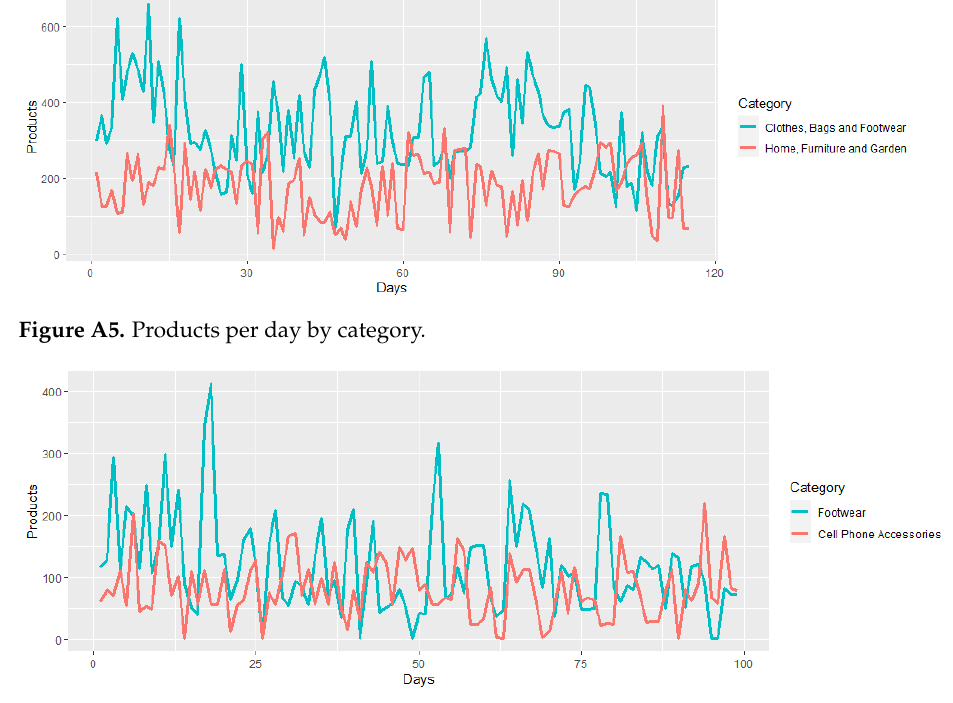
Figure A6. Products per day; Footwear vs. Cell Phone